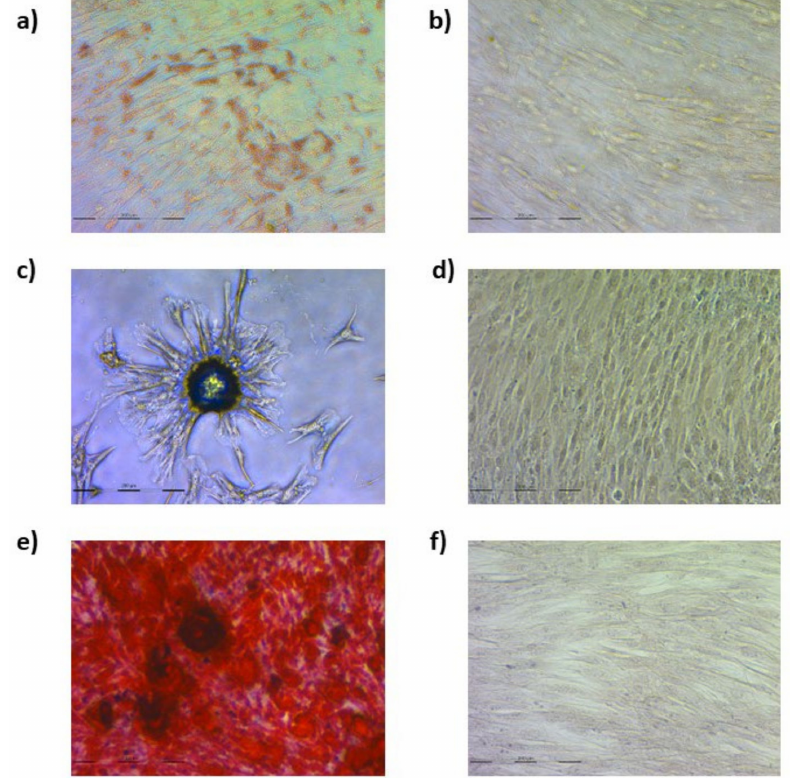
Figure 1. oBM-MSC staining for adipogenic, chondrogenic, and osteogenic differentiation. Oil red O staining of cells cultured for 8 days in adipogenic differentiation medium ( a ) and basal medium ( b ); alcian blue staining of cells cultured for 15 days in chondrogenic ( c ) and basal medium ( d ); and alizarin red staining of cells cultured for 21 days in osteogenic differentiation medium ( e ) and basal medium ( f